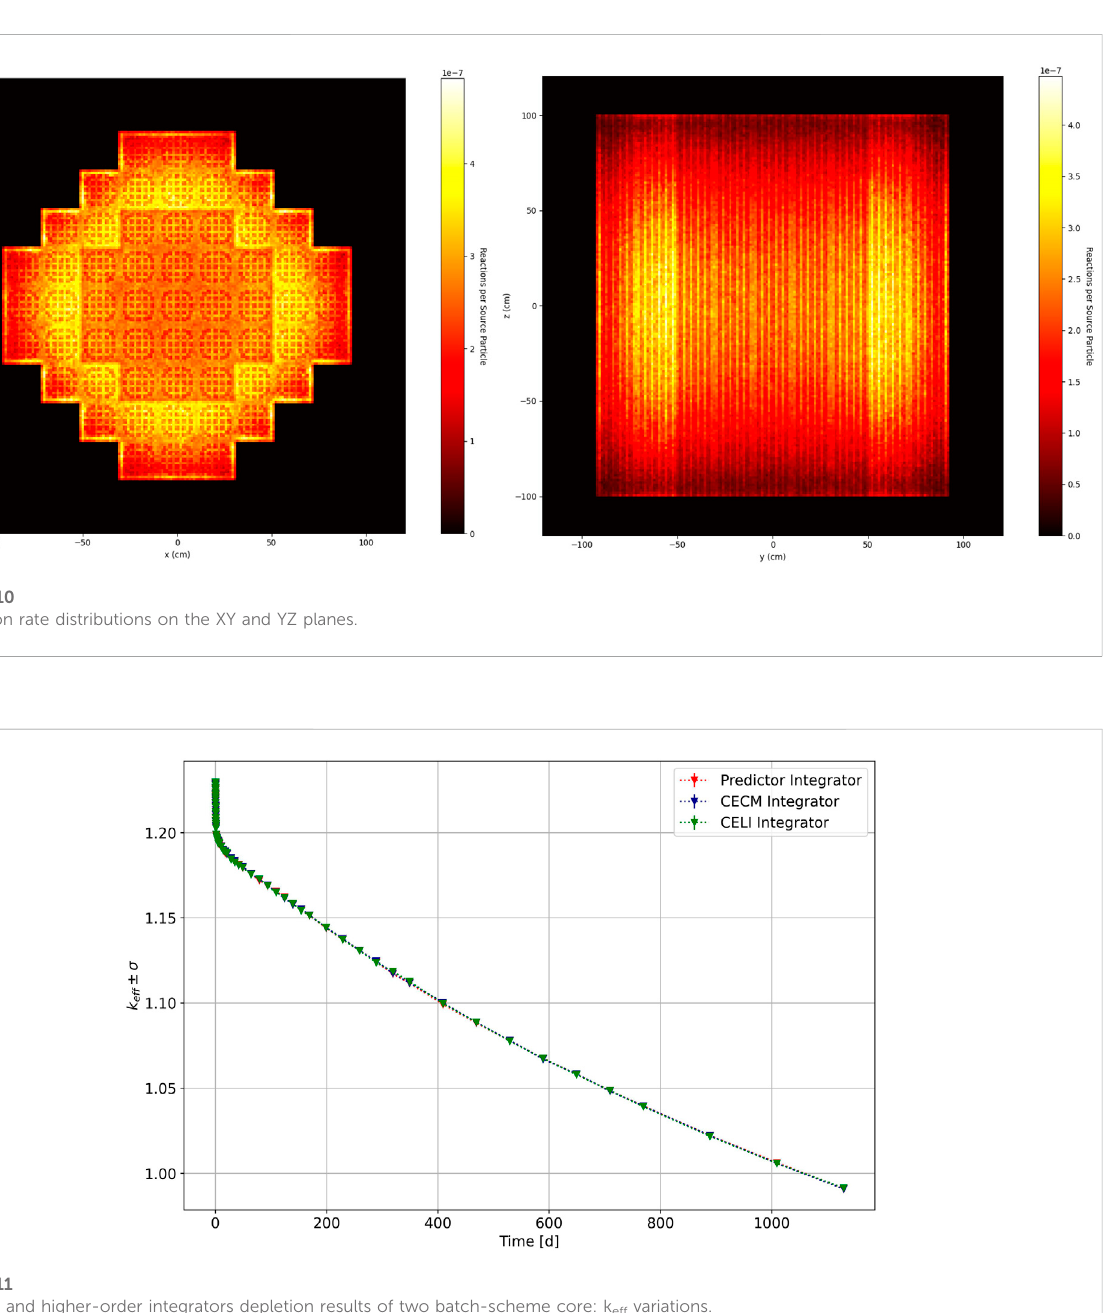
FIGURE 11 Predictor and higher-order integrators depletion results of two batch-scheme core: k eff